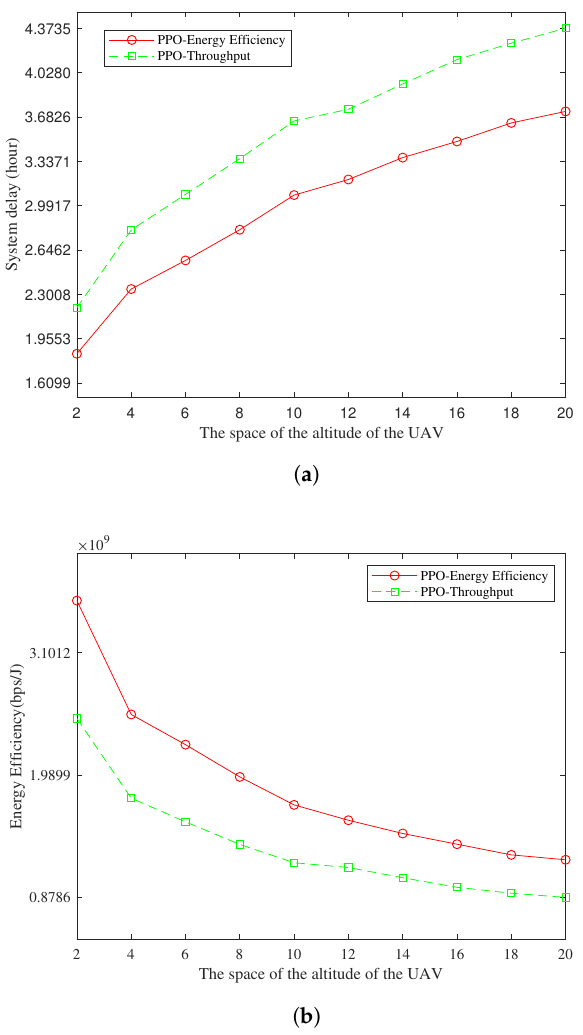
Figure 4. System performance with the space of the altitude of the UAV. ( a ) System delay with the space of the altitude of the UAV; and ( b ) Energy efficiency with the space of the altitude of the UAV. According to Figure 5a, the system delay decreases with the increase in the minimum throughput, because the reduction in detectable sensors reduces the flight delay and hovering delay of the UAV. In addition, the gap between the PPO-Energy Efficiency and PPO-Through delay performance is reduced because the number of sensors satisfying SNR is reduced, making PPO-Energy Efficiency less flexible to reducing delay through the energy-saving movement of UAVs. According to Figure 5b, the system energy efficiency increases with the increase in the minimum throughput. Due to the reduction in detectable sensors, the movement time for the transition state of the UAV is reduced, so the energy efficiency is